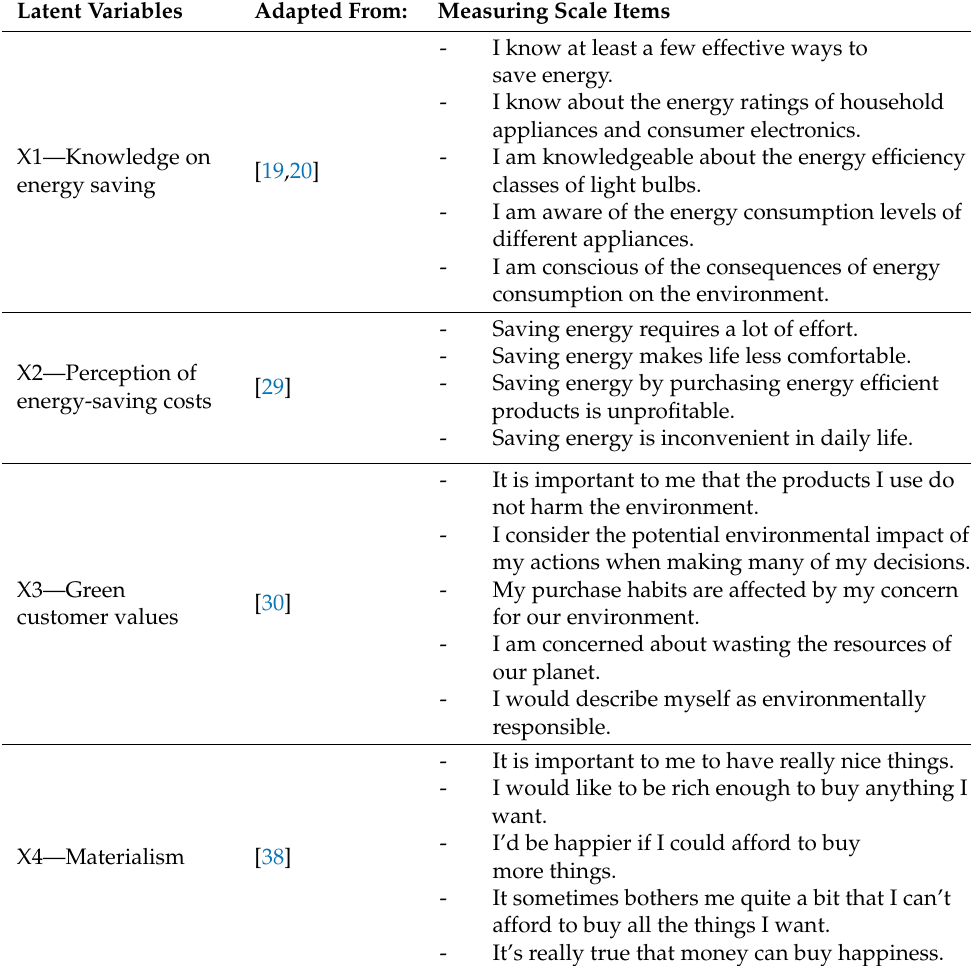
Table 1. Statements in each latent independent